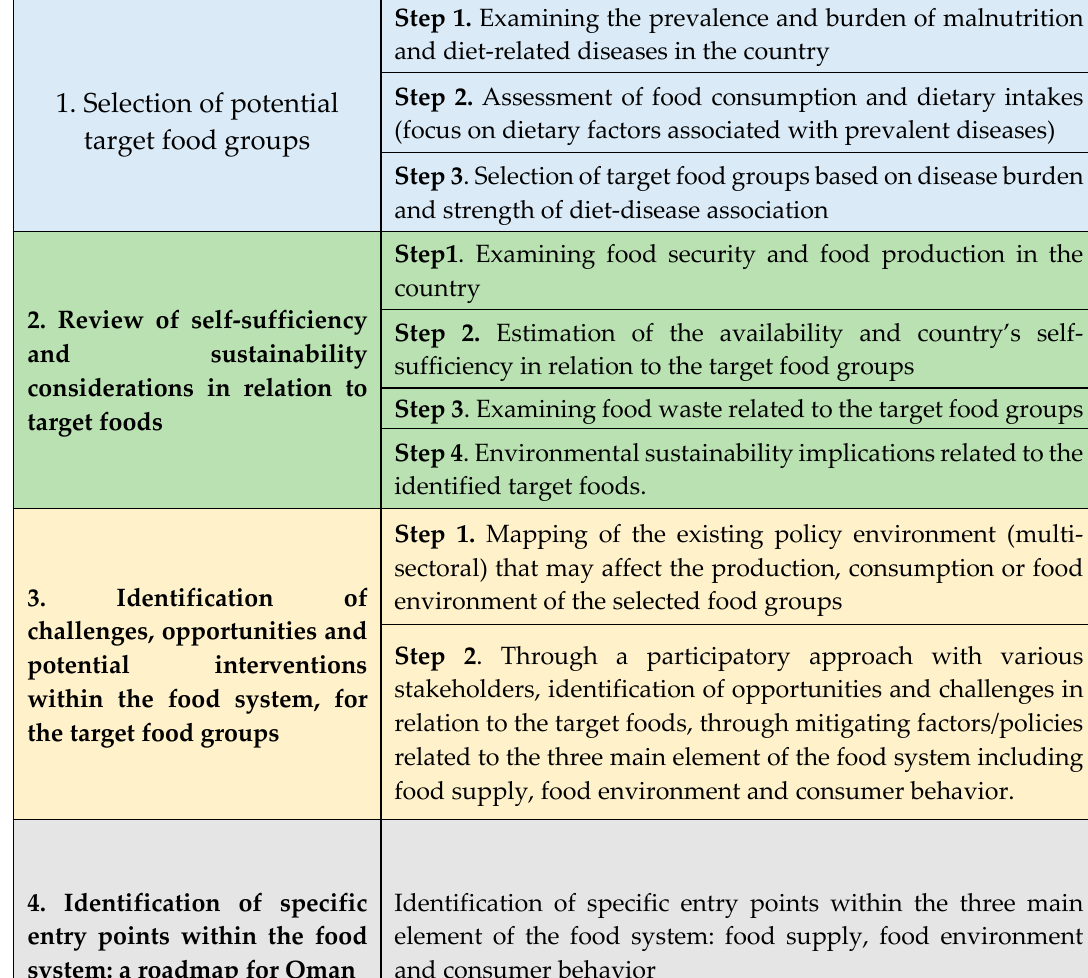
Figure 1. A four staged process to identify priority foods and interventions within the food system.